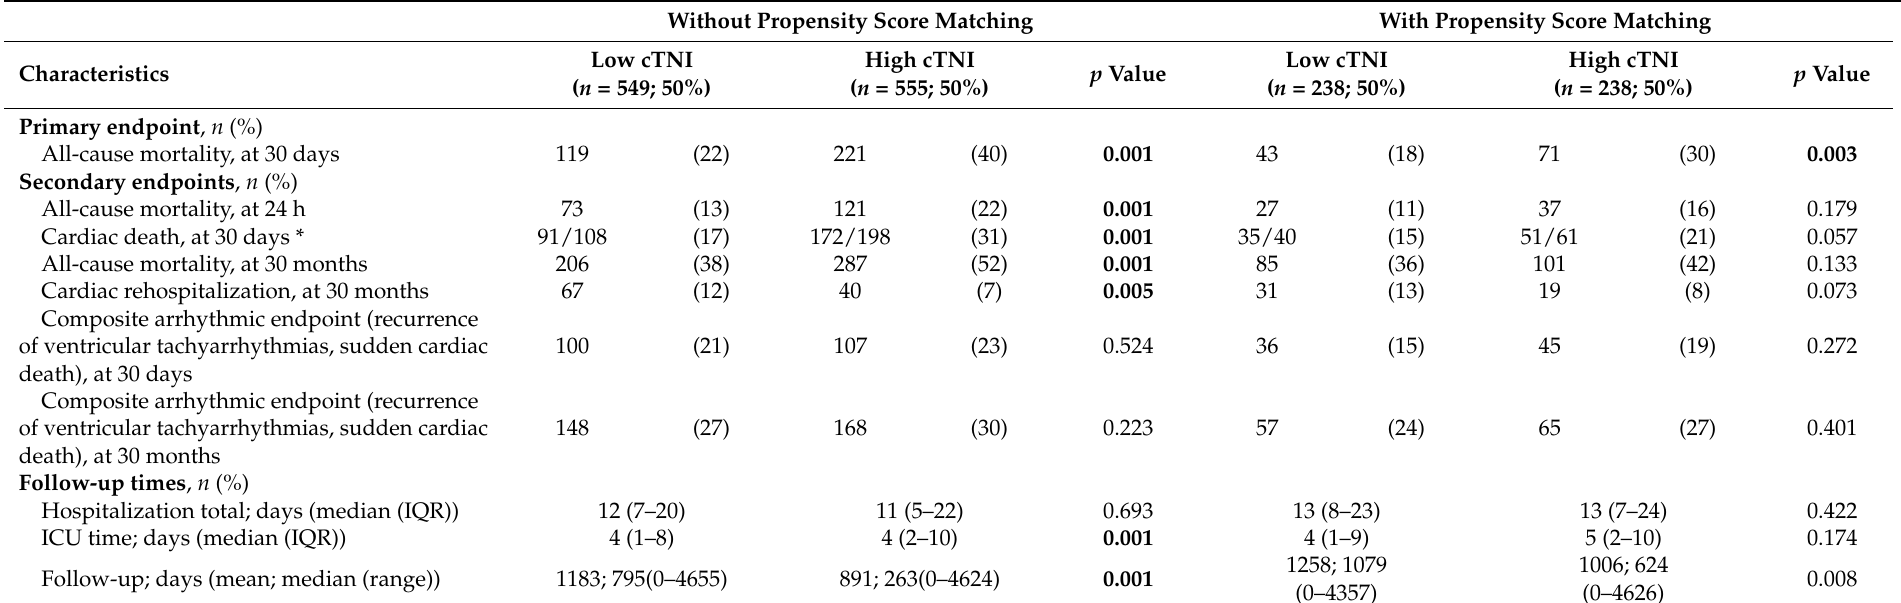
Table 3. Endpoints and follow-up data before and after propensity score